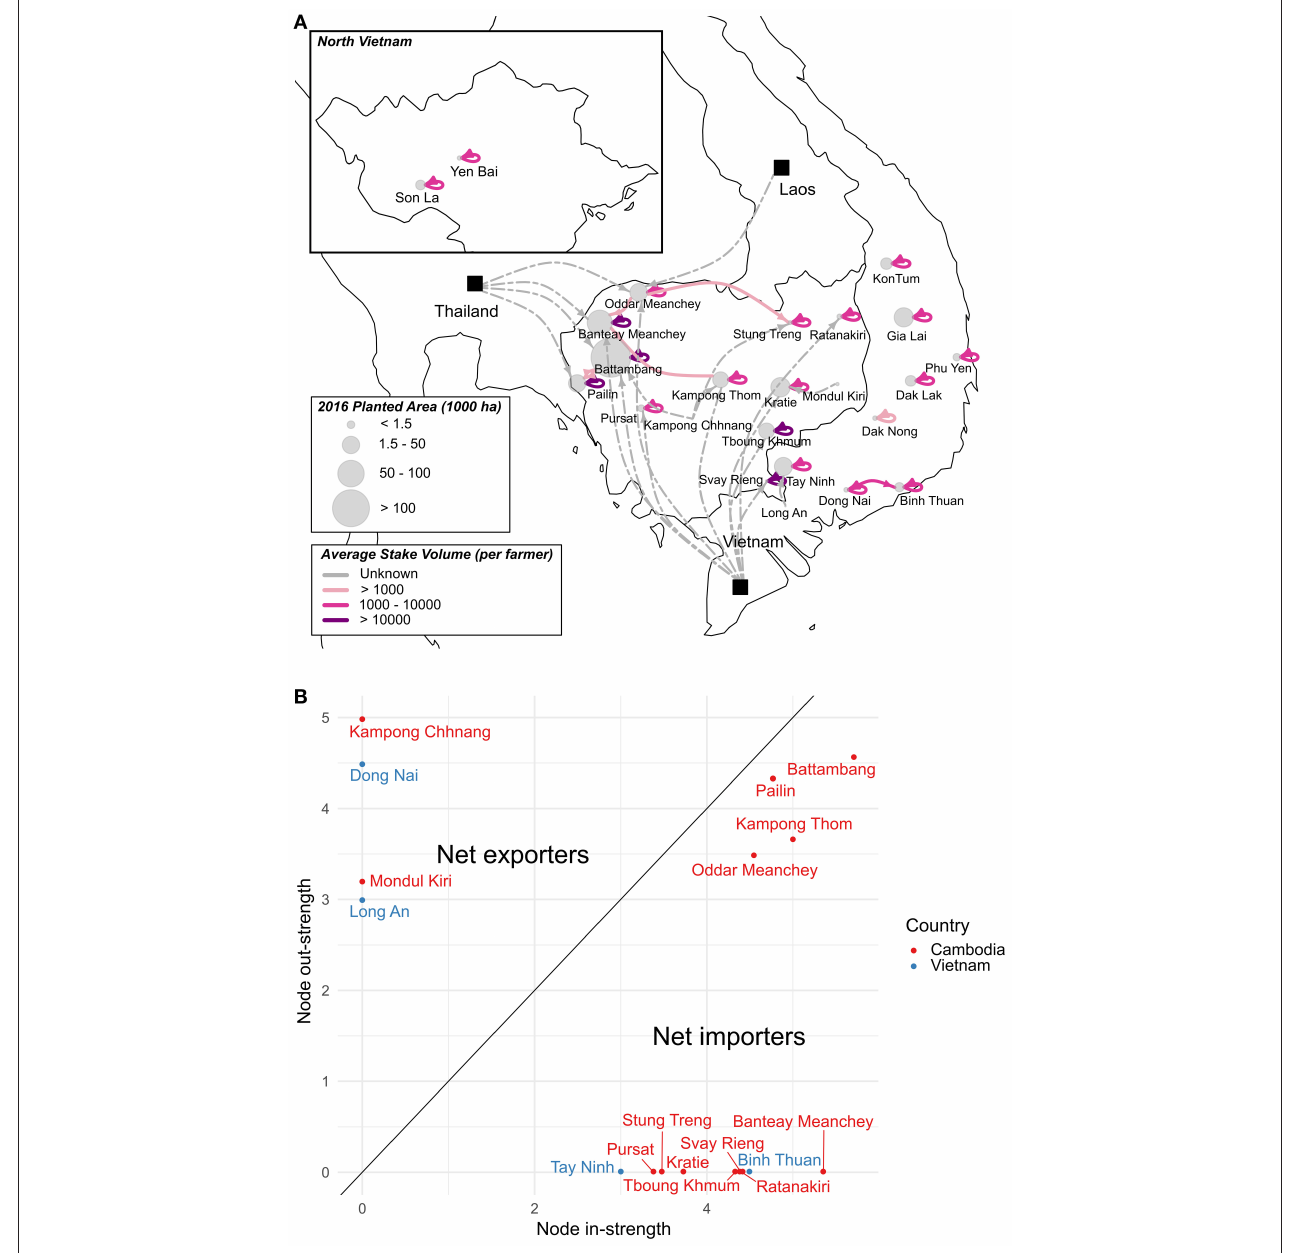
FIGURE 3 | (A) Network graph representing stake exchange per surveyed farmer (links) between provinces (nodes) in 2016, aggregated from national-level survey of farmers ( n = 240) in 16 districts in Cambodia, and 15 districts in Vietnam ( n = 206). The inset map area represents Northern Vietnam. Self-loops indicate provisions that occurred within a given province. Link color represents volume of stakes exchanged, corrected by number of farmers surveyed (stakes exchange per farmer). Gray hashed links reflect instances of stake transactions from unsurveyed regions, where there was no formal sampling effort. Node size represents provincial cassava planted area in 2016 (ha). Black, square nodes represent stake movements where country, but not province name was provided by survey respondents. Note that the only stake movement data for Thailand and Laos were those mentioned by Cambodian and Vietnamese respondents. Links listed with “unknown” destinations or origins are not illustrated. Because high-production districts within provinces were targeted for this survey, volumes of seed exchange should be considered the upper-end of the likely province-wide average stake exchanges per farmer. (B) Log10-transformed node strength, the weight of links (in this case, number of stakes per farmer), by province. In-strength is the number of incoming stakes, out-strength is the number of outgoing stakes. Provinces above the bisectrix can be considered net-exporters, while provinces below the bisectrix represent net-importers.